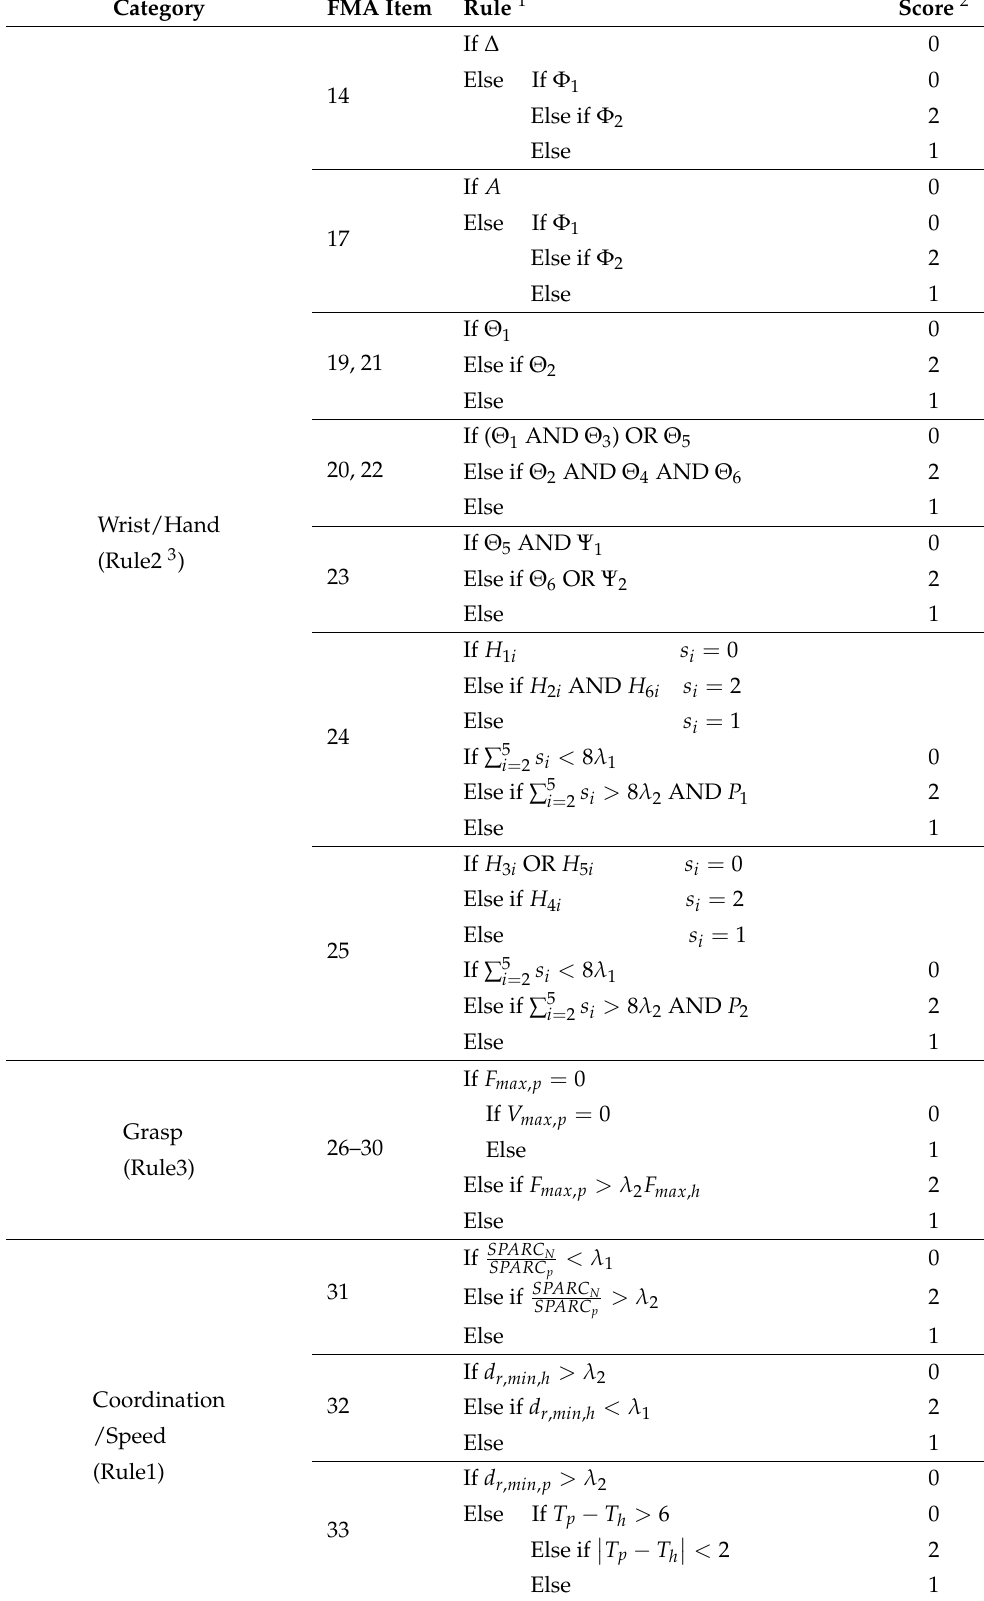
Table A1. Logic Classification